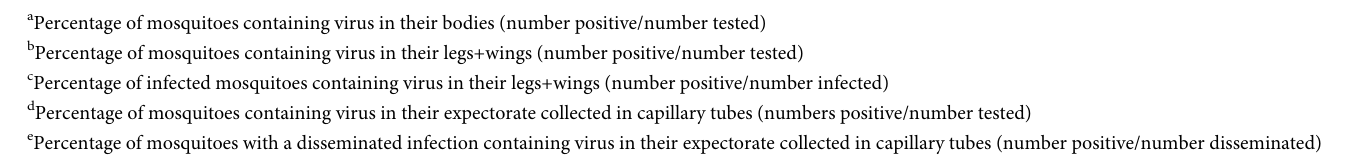
replication of the virus in the mosquito tissues (Fig 1). There was a significant difference between the titres in the bodies of blood-fed Cx . sitiens and Cx . annulirostris , with a higher titre in Cx . annulirostris ( P = 0.0149). This was also the case in the bodies of injected mosqui- toes, with slightly higher titres on average detected in Cx . sitiens ( P = 0.0058). Titres were sig- nificantly lower in the mosquito bodies of the blood-fed mosquitoes than in the injected mosquitoes ( P < 0.0001 for both species). In contrast, virus titres in saliva expectorates of injected mosquitoes were not significantly different between Cx . sitiens and Cx . annulirostris ( P = 0.3712). Similarly, titres in the saliva were not significantly different between injected and blood-fed Cx . annulirostris , although this could be the result of a longer extrinsic incubation for bloodfed mosquitoes ( P = 0.6977).